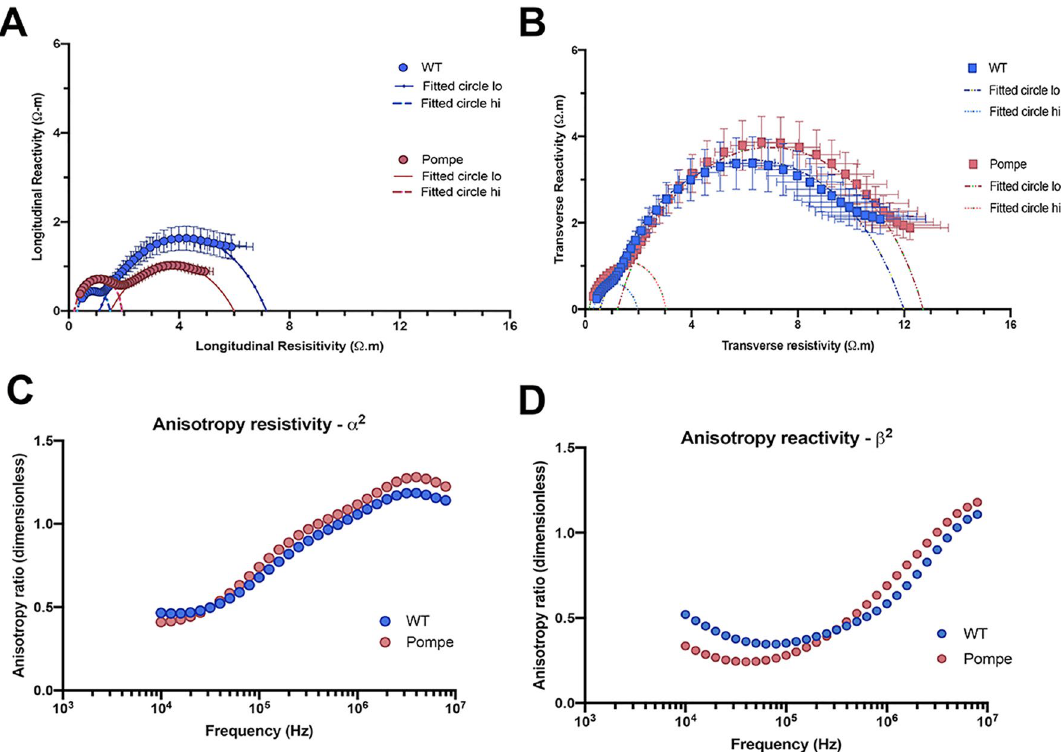
Figure 5. Resistivity and reactivity data for WT and Pompe gastrocnemius muscle fitted to the Cole–Cole resistivity model. Graphs showing the real (= Resistivity) versus the imaginary (= Reactivity) part of the complex resistivity spectrum for WT and Pompe GA muscle in the longitudinal ( A ) and transverse directions ( B ). Mean values and standard errors shown. The solid, dashed and dotted lines represent the model fit corresponding to respective high and low frequency arcs. Mean resistivity anisotropy ratio α 2 ( C ) and mean reactivity anisotropy ratio β 2 ( D ) for Pompe and WT mice indicating that the anisotropy ratios are unequal, i.e., α 2 ≠ β 2 at all